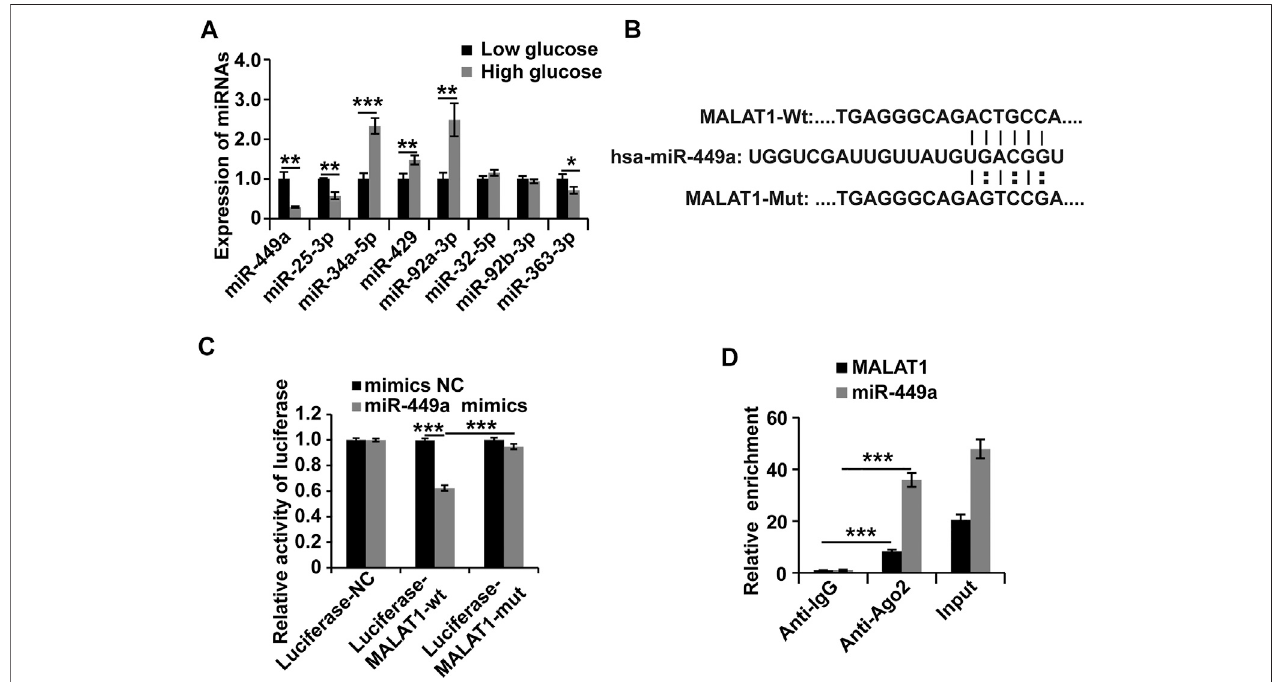
FIGURE 3 | MALAT1 interacts with miR-449a in HGSMCs. (A) qPCR analysis was conducted to detect the endogenous microRNAs associated with MALAT1 in HGSMCsunderHGconditionsforabout48 h. (B) PredictedbindingsiteofmiR-449aintheMALAT1sequence. (C) luciferasereporterassayanalysisoftheinteractionbetween MALAT1 and miR-449a. (D) RIP assay analysis of the interaction between MALAT1 and miR-449a. U6 was used as an internal control. *** p < 0.001, ** p < 0.01, * p < 0.05.